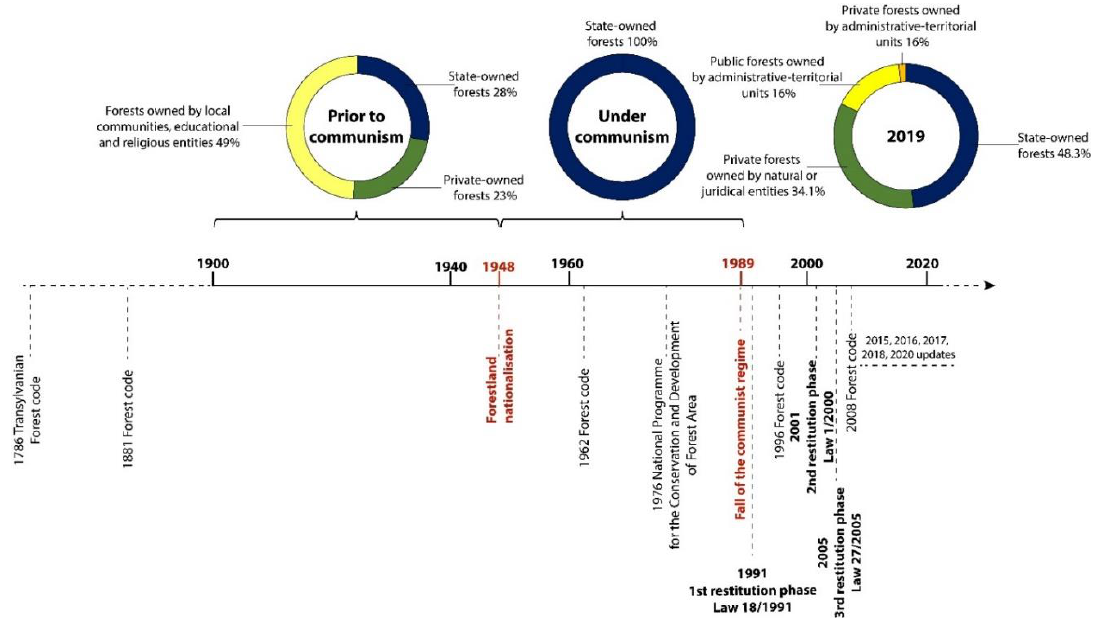
Figure 5. Forest ownership evolution, political cornerstones, and the progression of forestry-related legal frameworks.